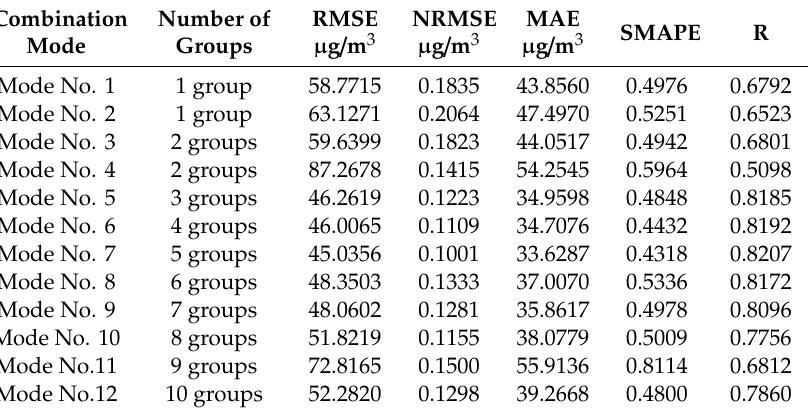
Table 2. Comparison of prediction results with di ff erent